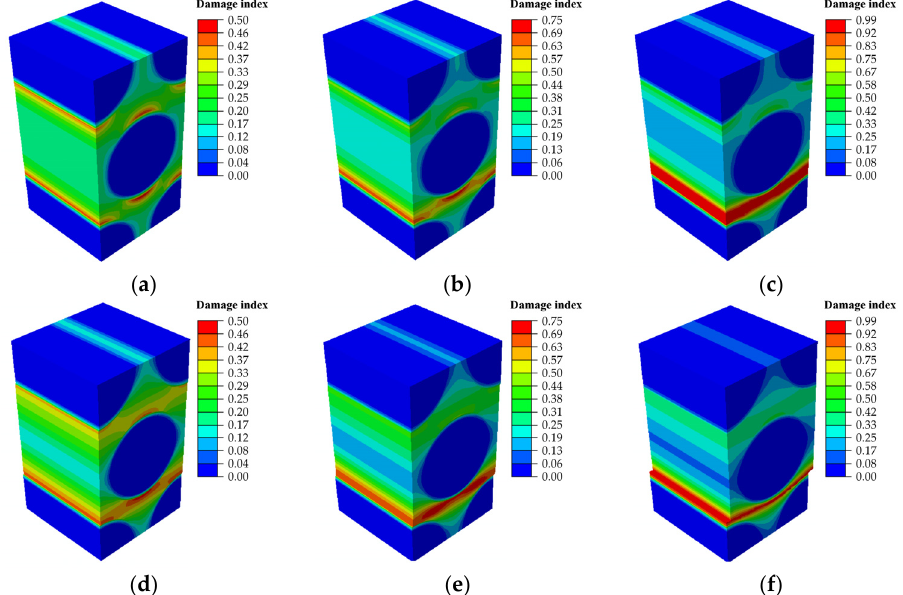
Figure 11. Damage evolution in the transverse tensile and shear cases: ( a ) damage index of 0.5 in transverse tension, ( b ) damage index of 0.75 in transverse tension, ( c ) failure in transverse tension, ( d ) damage index of 0.5 in shear, ( e ) damage index of 0.75 in shear, and ( f ) failure in